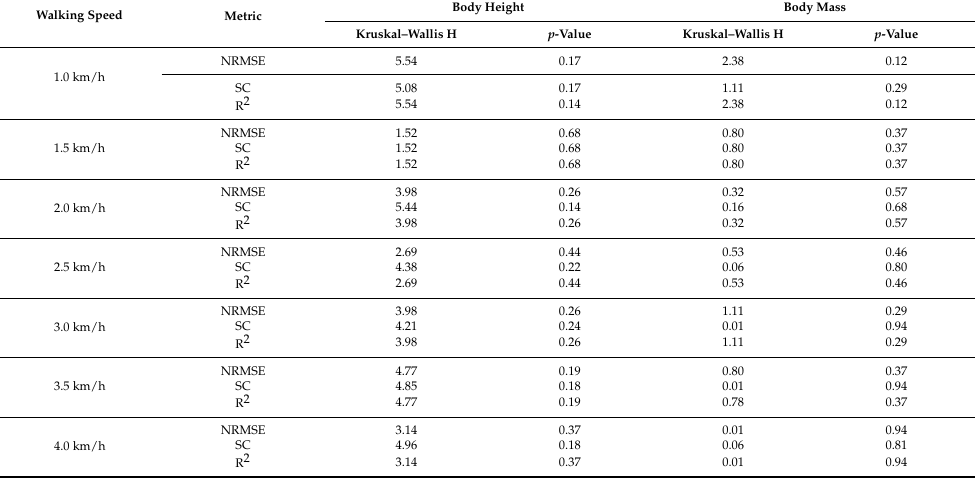
Table A2. The p -value of the independent samples test for NRMSE, SC, and R 2 variables, considering the different body heights, body mass, and walking speeds, and a significance level of